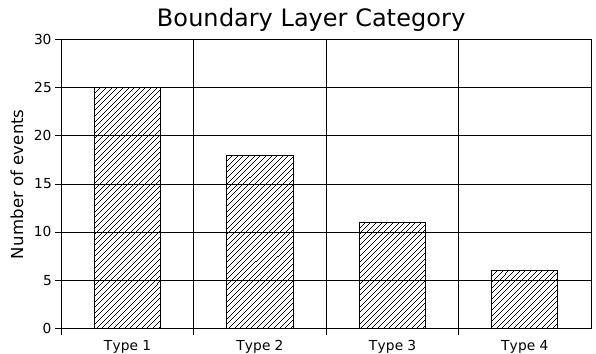
Fig. 15. Histogram of boundary layer classifications for the C1 and C3 crossings. There are 25, 18, 11, and 6 crossings of types 1 (no boundary layer) to 4 (extended high density boundary layer), re-